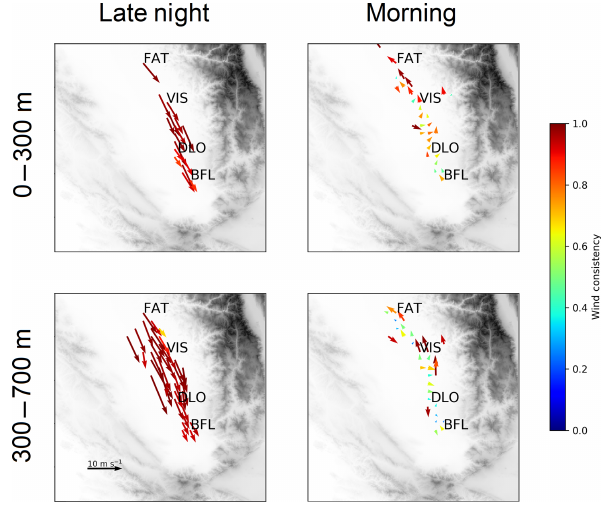
Figure 7. Wind consistency for late-night flights and morning flights in the NBL (0–300m) and the RL